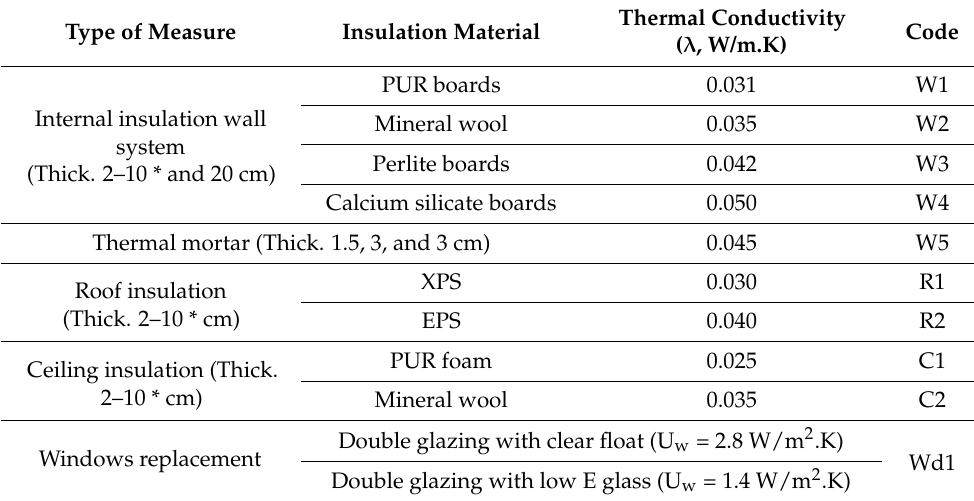
Table 1. Overview of the tested retrofit measures. Type of Measure